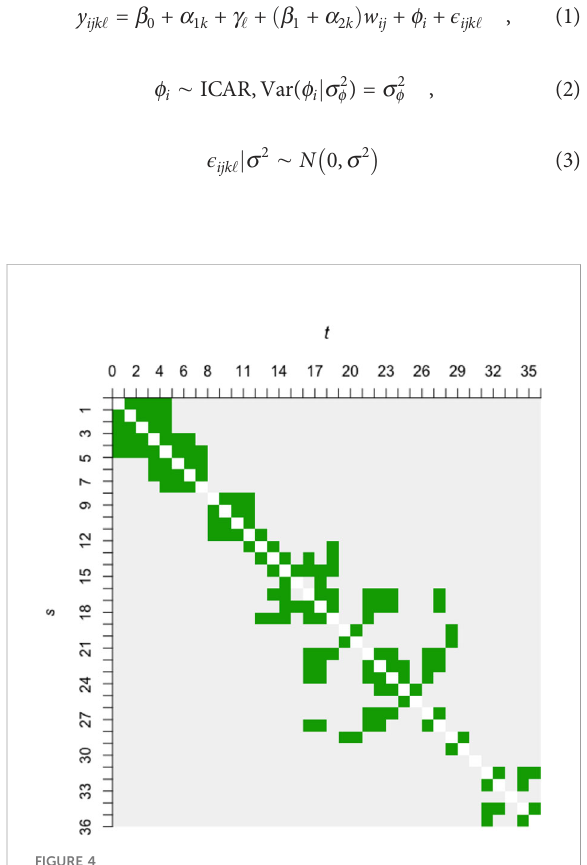
FIGURE 4 The adjacency matrix (symmetric) of 36 × 36 cells based on a 24 km threshold radius. Marshes s and t are considered neighbors if they are located within the threshold radius of each other, and the cell on the s -th row and t -th column of the adjacency matrix appears green. A gray cell denotes non-neighbors. White cells along the diagonal denote not applicable , as the notion of neighborhood between a marsh and itself is unde fi ned. Note that the cell labels run from 1 to 36 (not 38) due to the omission of Sites 16 and